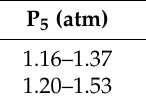
Table 1. Mixtures and conditions investigated during this study. Mixture Composition (Mol. Fraction) T 5